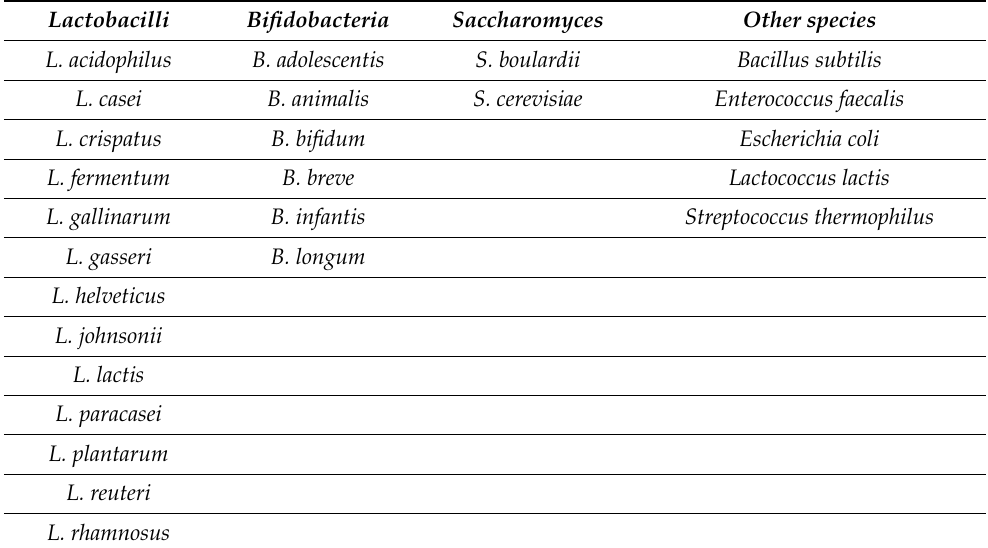
Table 2. List of probiotics strains commonly used. Lactobacilli